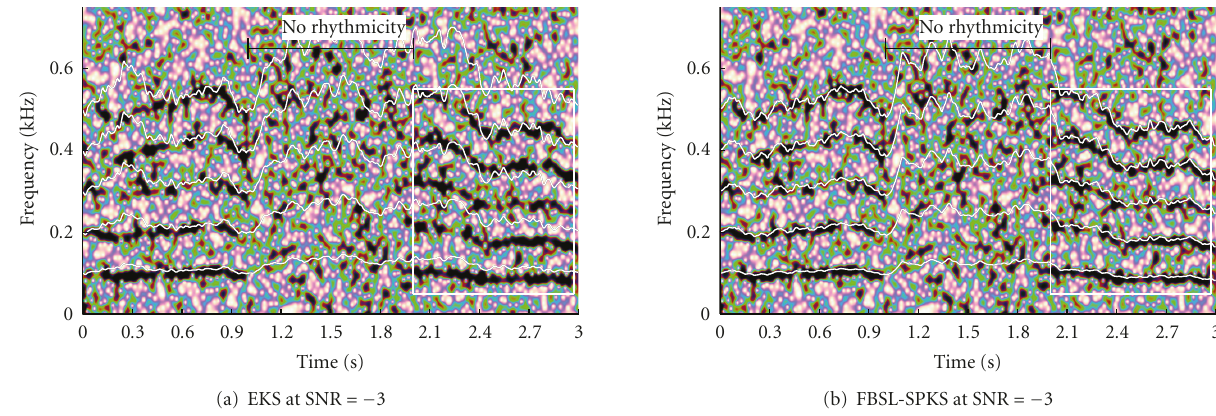
Figure 5: (a) Estimated frequencies using the EKS on top of an intermittent rhythmicity signal at SNR = − 3. (b) Estimated frequencies using the FBSL-SPKS on top of an intermittent rhythmicity signal at SNR = − 3.